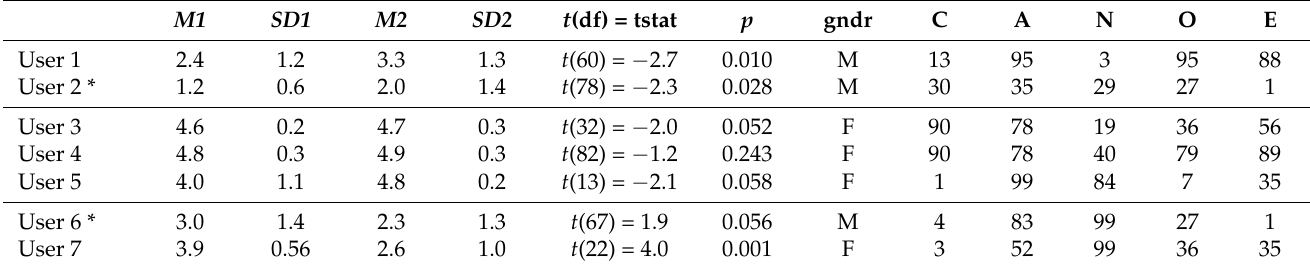
Table 2. Comparison of users according to the ratings of notifications with the evening